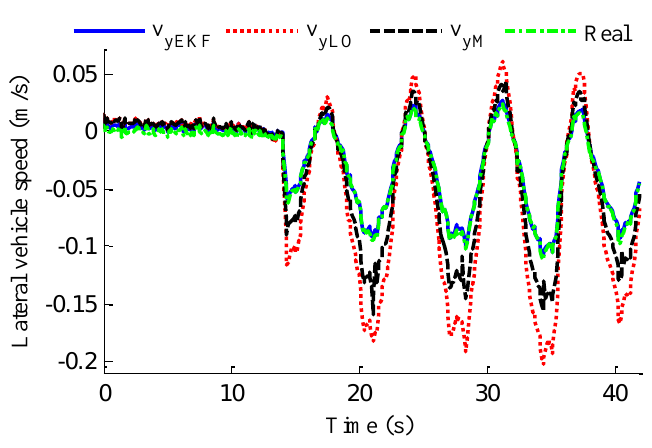
Figure 22. Fuzzy weight coefficient.